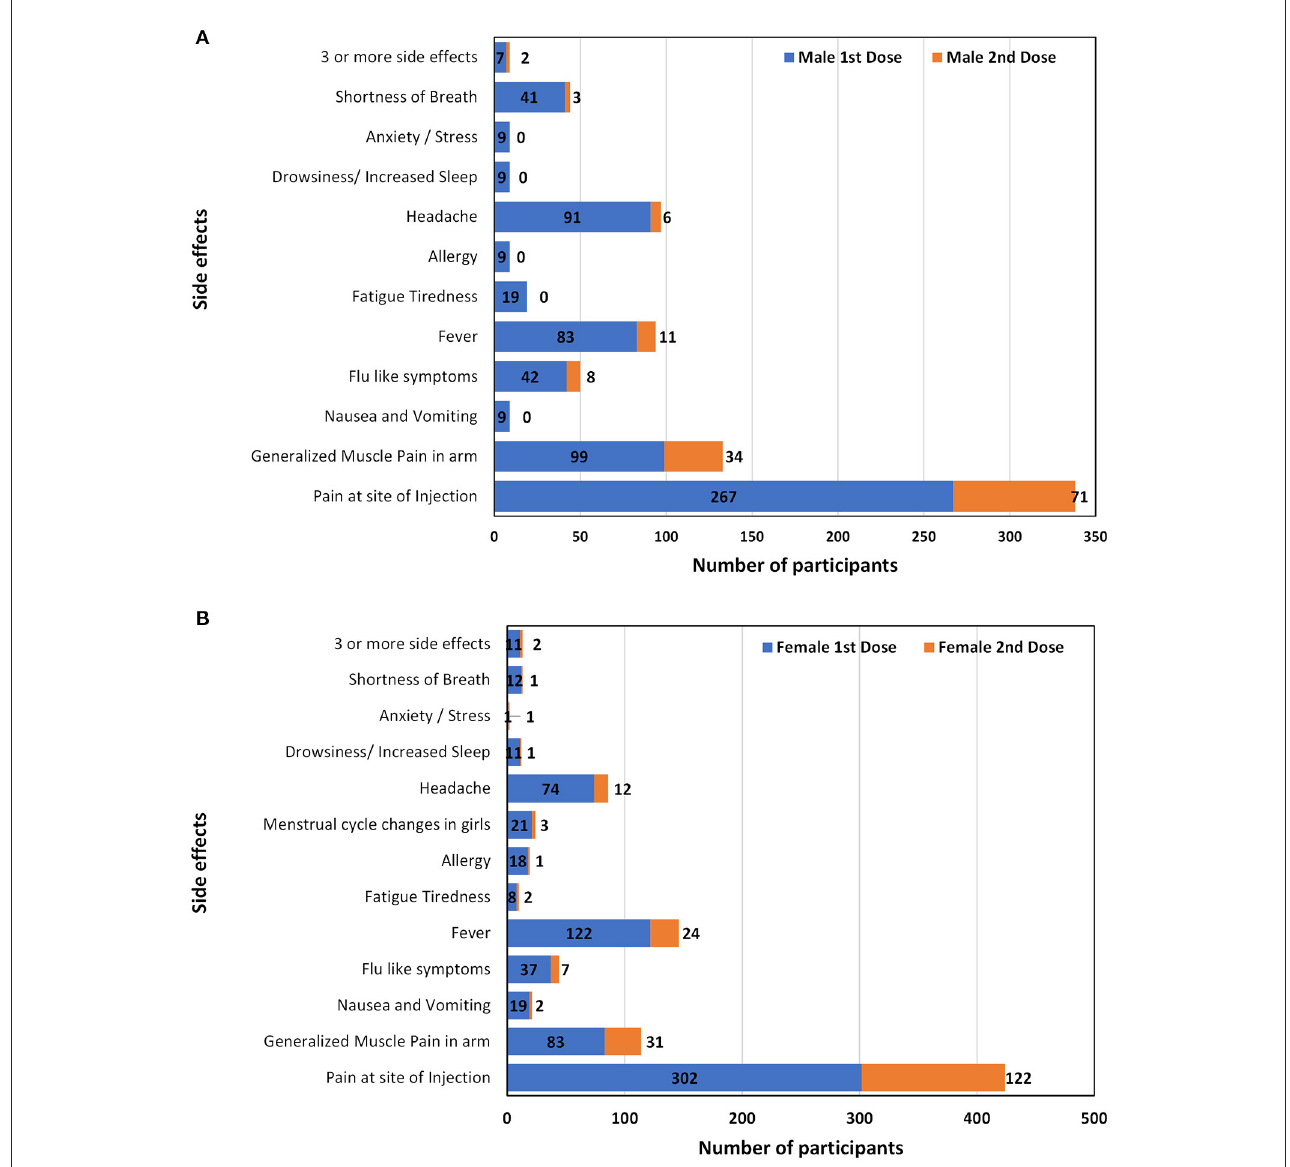
FIGURE4 Comparison of side effects after administration of first and second dose in male (A) and female participants (B)